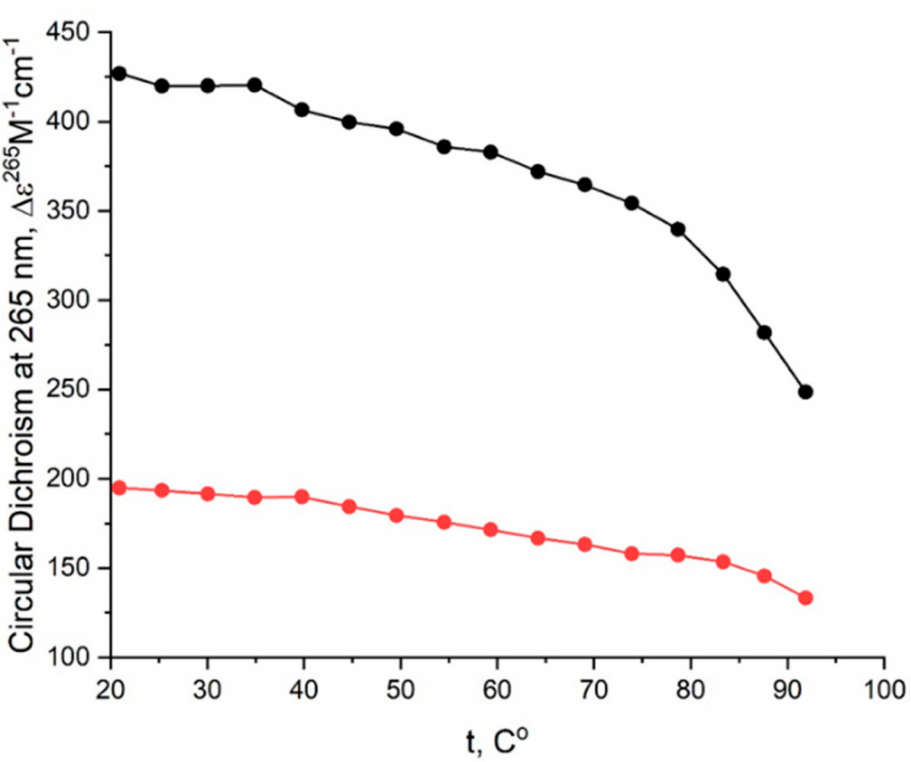
Figure A3. CD melting profile of GQs under study in the buffer C (140 mM NaCl, 10 mM KCl, 5 mM BaCl 2 ): AID-1-T (red), bi-(AID-1-T) (black).